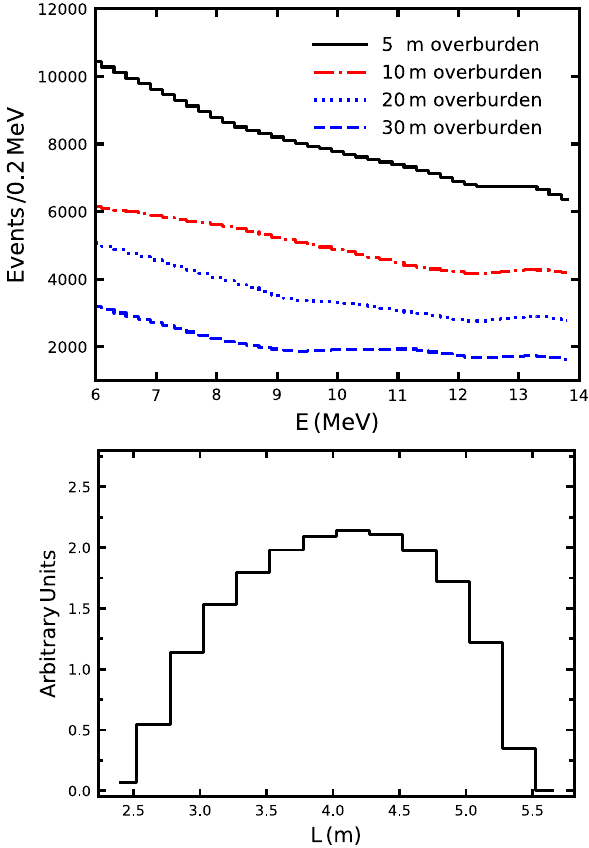
Fig. 4 The upper panel shows the energy spectra for fast neutron induced backgrounds with different overburdens. The normalized energy spectra are adopted as inRef. [71]. The neutrino energy isshown within the energy range of [ 6MeV , 14MeV ] . The lower panel shows the distance dependence of background event rates, which are universal for all the